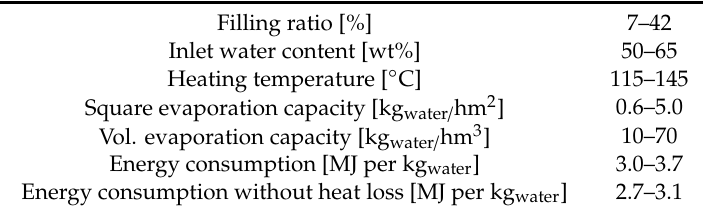
Table 2. Evaporation capacity of the drum dryer.